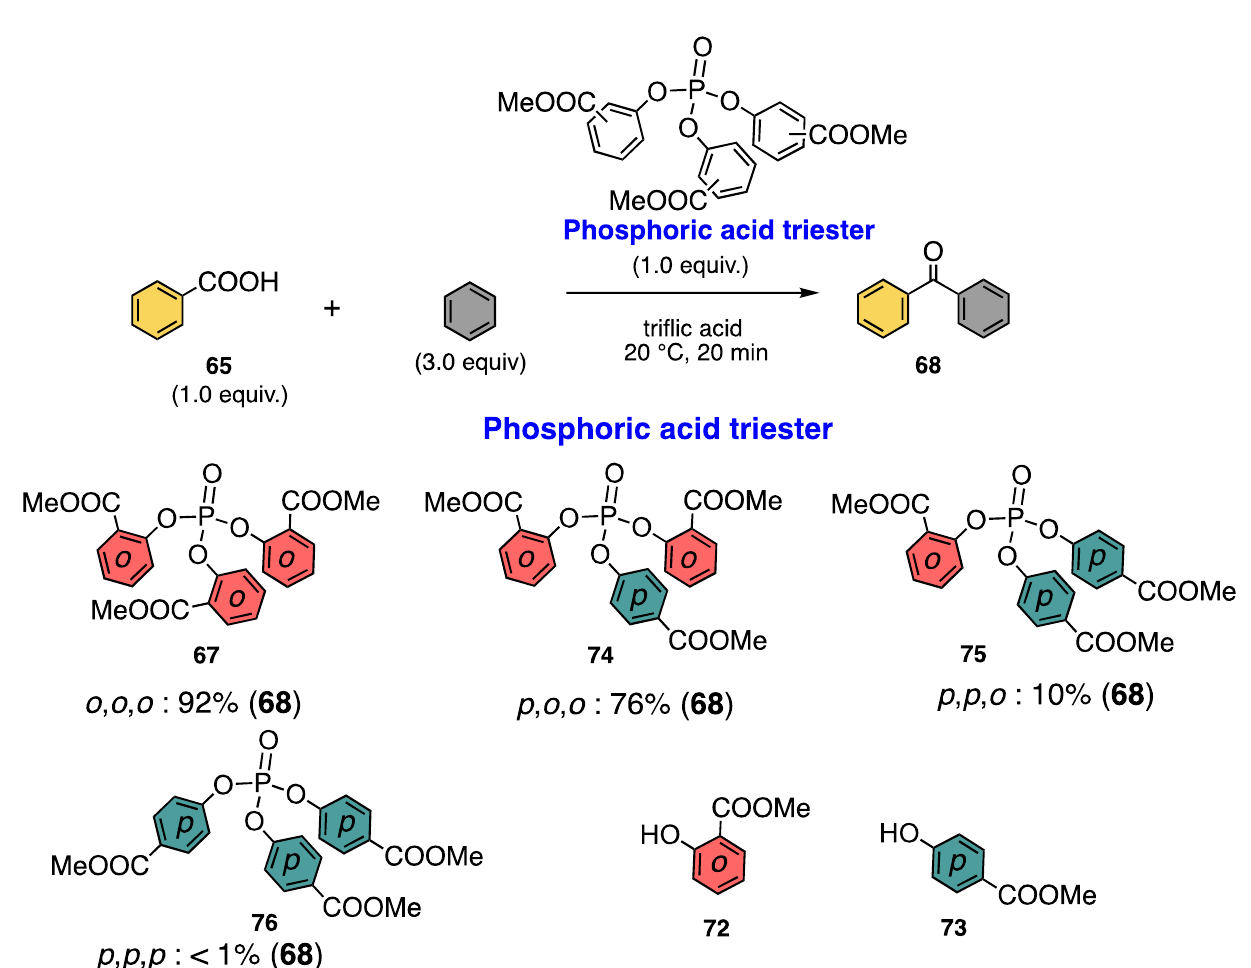
Scheme 18. Promoting effect of various phosphoric acid triester compounds containing o -methyl salicylate ( 72 ) or methyl 4-hydroxyl benzoate ( 73 ) moieties. Comparison of yields of product ( 68